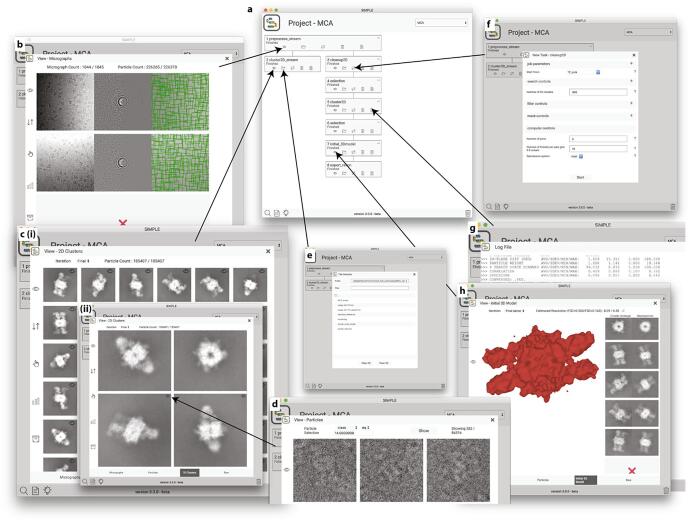
Graphical User Interface (GUI). (a) Project window with workflow graph outlining the executed processes. Each box represents a process with the execution directory as heading and a process indicator (running, finished, failed) just below. The clickable eye icon in the lower left corner of each box links to (b) viewable outputs. In this example, the (b) panel shows micrograph (left), background subtracted power spectrum/fitted CTF model (middle) and picked particle coordinates (right) generated by 1_preprocess_stream. (c(i)) Following stream 2D analysis (process #2, executed after #1 stream pre-processing), the viewer links to the class averages produced. (c(ii)) The class averages can be closely inspected and link to (d) a particle viewer via the eye icon in the upper right corner of each class average, allowing visualization of the particles associated with each class and inspection of their associated statistics. (e) The folder icon in each box allows inspection of the output files produced in the execution directory. Outputs that can be rendered on screen link to viewers. (f) The process icon (cyclic double arrow) link to the task control window, where input parameters are arranged in dropdown menus according to their categorization. Only dropdown menus with required inputs are expanded by default. In this example, the categories are job parameters, search controls that modify optimization behavior, filter controls that modify Fourier filtering behavior, mask controls and computer controls used to change how the task is executed, i.e. number of threads etc. (g) The text file icon allows inspection of the log file, to which all SIMPLE 3.0 subprocesses concatenate their output. The log file is used to report subprocess exceptions and should be inspected when the process indicator is in the “failed” state. (h) When 3D volumes are available they can be visualized and the volume viewer supports 3D rendering over remote connection. Shown here is the output from 7_initial_3Dmodel, which in addition to the initial 3D reconstruction shows the class averages used and the associated re-projections of the volume for validation.